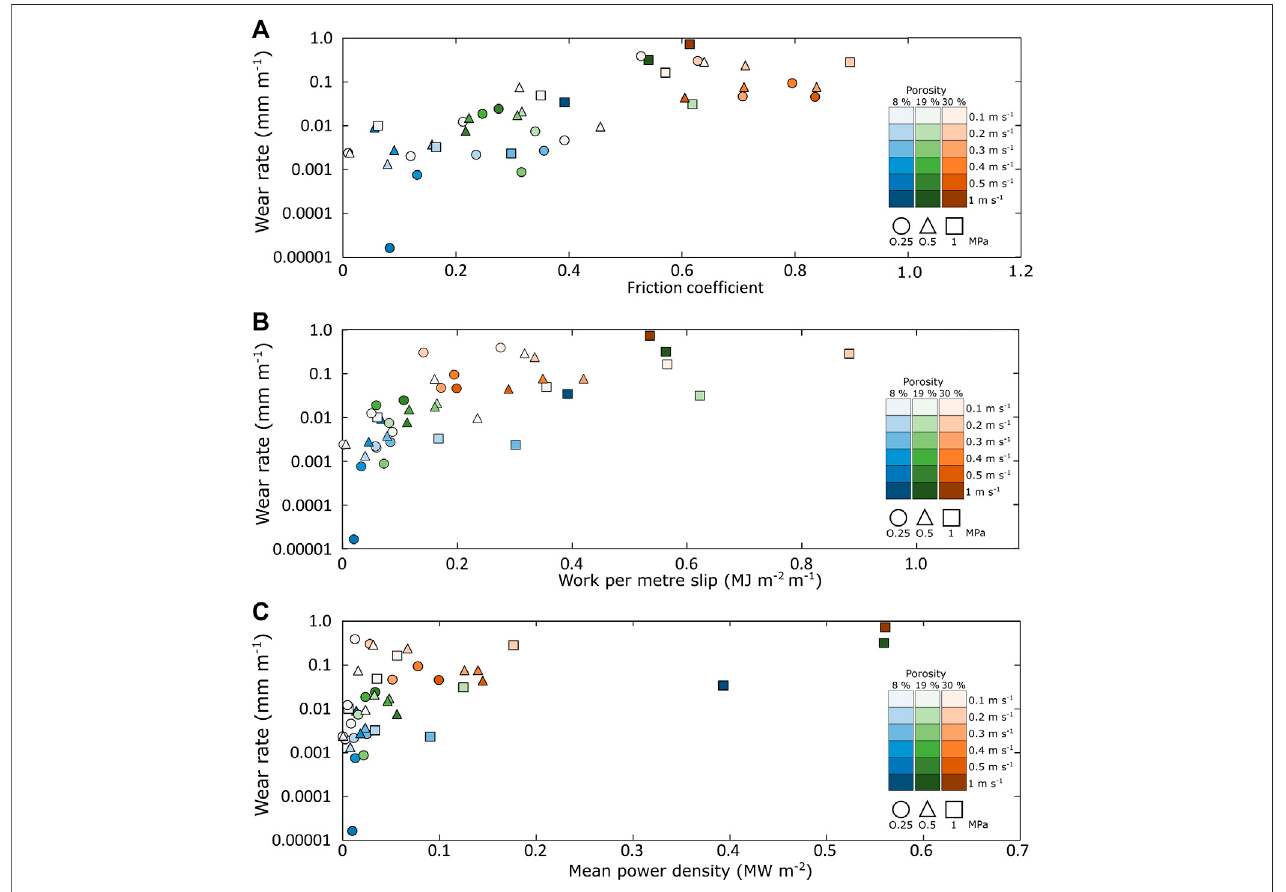
FIGURE 4 | (A) Wear rate related to friction coef fi cient for all tests. High porosity results in higher frictional coef fi cients and higher wear rates. (B) Wear rate as a functionofworkpermetreslip( W M ). (C) Wearrateasafunctionofpowerdensity( P D ).Higher W M and P D associatedwithhigherporositiesandhigherwearrates.Allwear rates have been corrected for thermal expansion using coef fi cient of expansion and thermal data recorded during